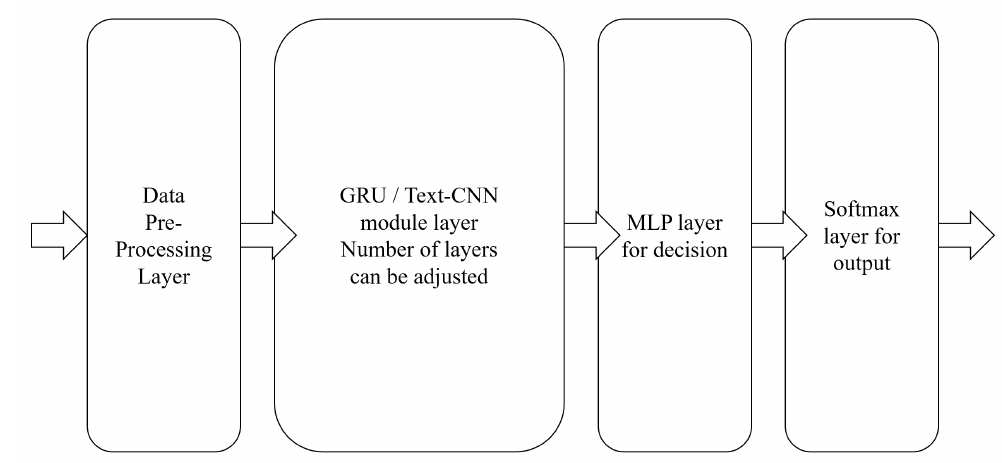
Figure 5. The model of the